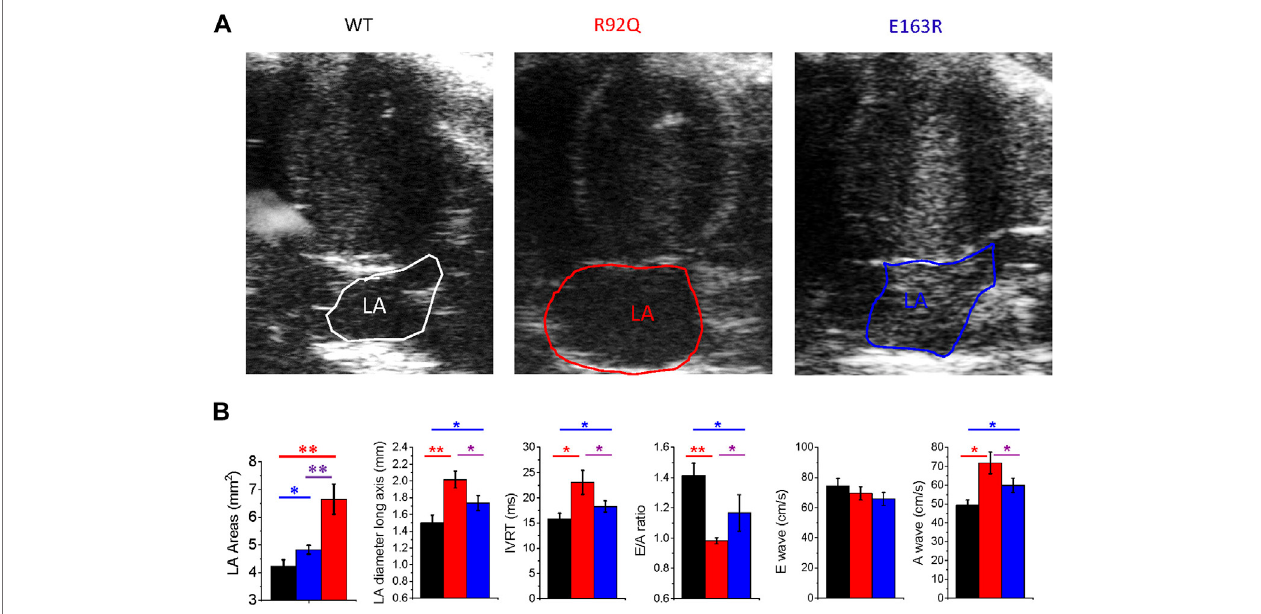
FIGURE 2 | Echocardiographic measurements in WT and cTnT mutant mouse models. (A) Representative echocardiographic images of left atrial area (LA) of WT, R92QandE163Rmice. (B) ComparisonofLAareas,maximalanteroposteriorleftatrialdiametermeasuredfromparasternallongaxisview,ratiobetweenEandAwaves (E/Aratio),isovolumicrelaxation time (IVRT), E-wave andAwaveinmice from thethreestudycohorts.Statisticaltests: One-wayANOVA withTukeycorrection. Dataare Means ± S.E.M. from 10 mice per group. * = 0.05 > p > 0.01 ; ** = 0.01 > p > 0.001.